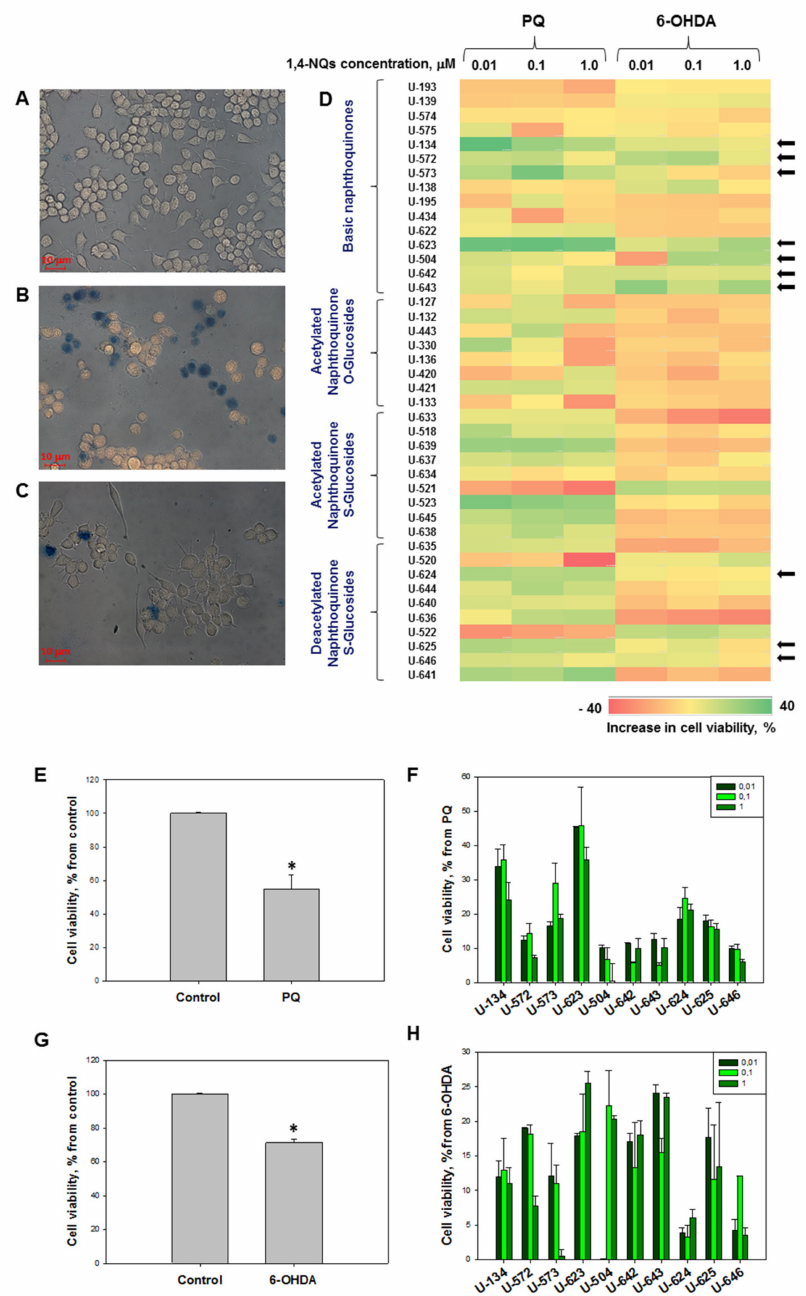
Figure 1. 1,4-NQs protect Neuro-2a cells against the neurotoxicity of PQ and 6-OHDA. ( A ) control cells; ( B ) cells cultivated in the presence of 6-OHDA (90.0 µ M) for 24 h; ( C ) cells pretreated with U-623 (1.0 µ M) and cultivated in the presence of 6-OHDA for 24 h. After incubation, the cells were stained with Trypan blue dye. ( D ) heat map visualization of the influence of 1,4-NQs on the viability of Neuro-2a cells cultivated in the presence of neurotoxins, PQ or 6-OHDA. Data are normalized to the viability of cells treated with neurotoxins alone (negative control). Arrows indicate the compounds protecting cell viability in the presence of PQ and 6-OHDA. ( E , G ) quantification of the effect of PQ (1.0 mM) and 6-OHDA (90.0 µ M) on cell viability. ( F , H ) quantification of the impact of 1,4-NQs on the viability of cells incubated in the presence of PQ or 6-OHDA. Cell viability was evaluated by the MTT method. Data are presented as m ± se ( n = 3). * p < 0.05 compared to cells exposed to PQ or 6-OHDA